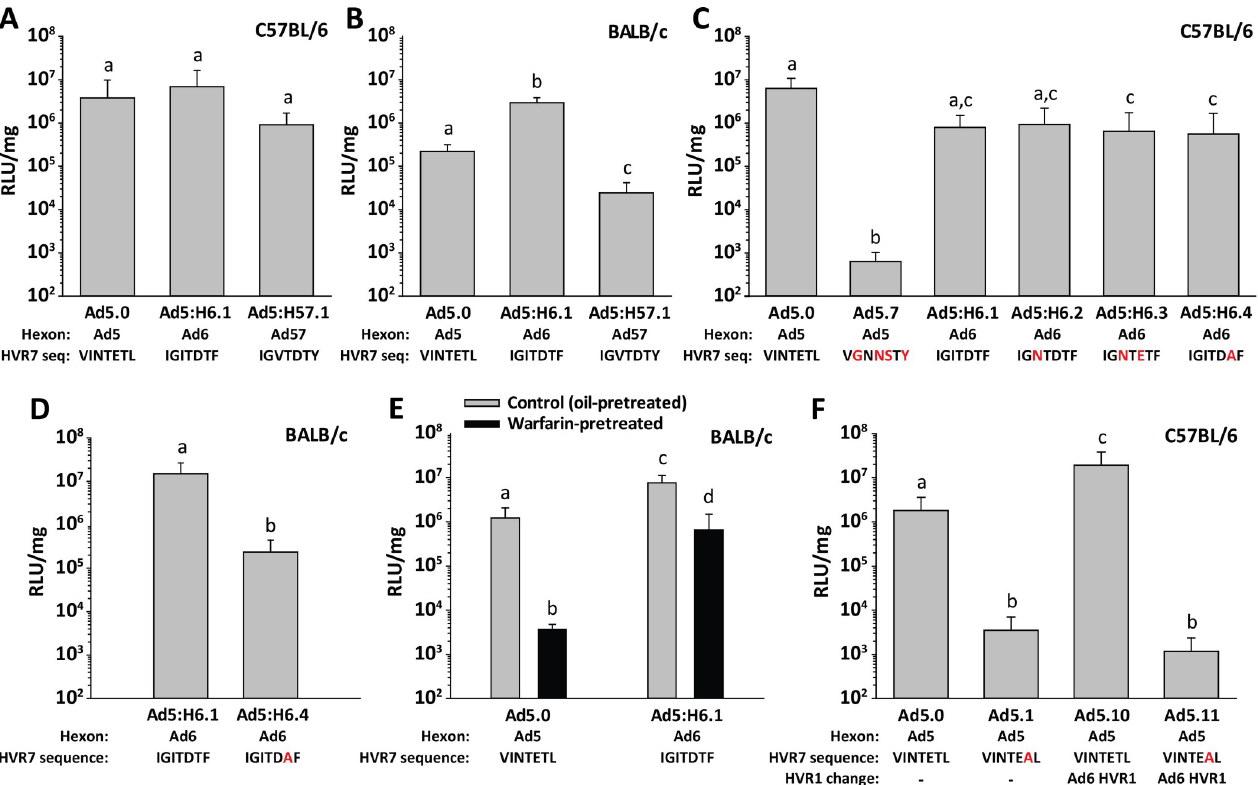
Fig 9. Liver transduction by Ad5 vectors containing chimeric hexon from Ad6 and Ad57. Mice were injected IV with 4x10 11 vp/kg of vector, and liver luciferase expression was measured 48 h later. Liver luciferase was evaluated after injection of Ad5 vector (Ad5.0) or vectors with chimeric hexon from Ad6 or Ad57 in (A) C57BL/6 mice or (B) BALB/c mice. (C) Liver luciferase after IV injection of C57BL/6 mice with vectors that contain chimeric hexon from Ad6. Mutated residues in HVR7 are indicated by red letters. Liver transduction with Ad5.0 (normal Ad5 vector) and Ad5.7 (Ad5 vector with no ability to bind FX or FII) are included for comparison. (D) Liver luciferase after injection of Ad5:H6.1 or Ad5:H6.4 in BALB/c mice. (E) Effect on liver luciferase activity of depleting coagulation factors with warfarin, prior to injection of Ad5.0 and Ad5:H6.1 in BALB/c mice. (F) Swapping HVR1 from Ad6 into an Ad5 vector and evaluating liver luciferase in C57BL/6 mice. Ad5.0 and Ad5.1 have a normal Ad5 HVR1, while Ad5.10 and Ad5.11 have HVR1 from Ad6. Ad5.0 and Ad5.10 have a normal Ad5 HVR7, while the HVR7 region of Ad5.1 and Ad5.11 have a T425A mutation that abolishes binding of FX and FII. N = 4–8 per group. Statistical comparison was performed by ANOVA and Holm-Sidak post-hoc tests, and groups that do not share the same letter are significantly different from each other ( P � 0.05).